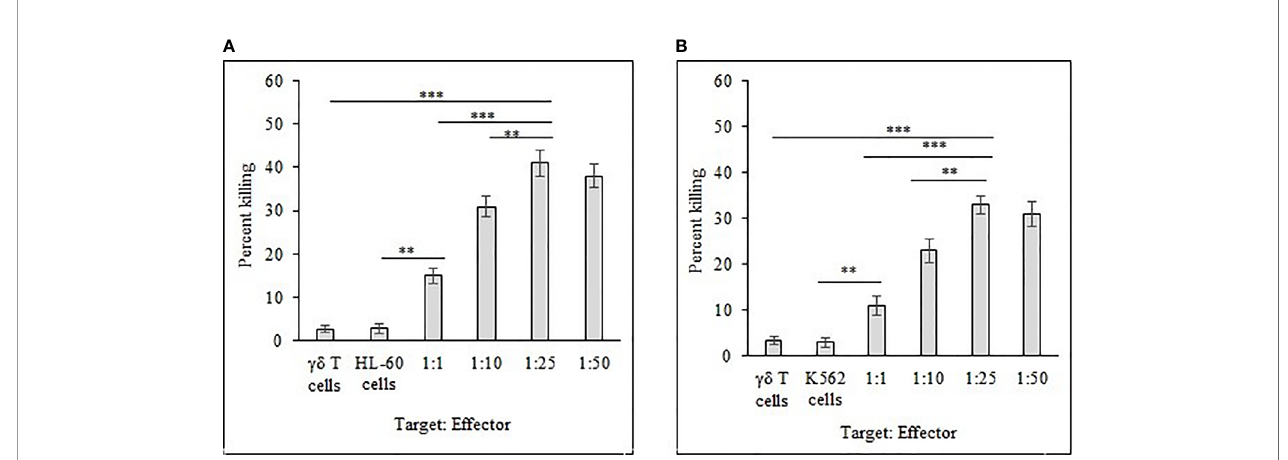
FIGURE 8 | Percent killing of HL-60 (A) and K562 (B) cancer cells by 14 day expanded gd T cells. Different T:E ratios were incubated together for a duration of 12 h. gd T cells and leukemia cancer cells (HL-60 and K562) alone served as controls. For both HL-60 and K562, *** P<0.001 on comparison of percent cell killing at the T:E ratios of 1:25 to 1:1. ** P<0.01 on comparison of percent cell killing at the T:E ratios of 1:25 to